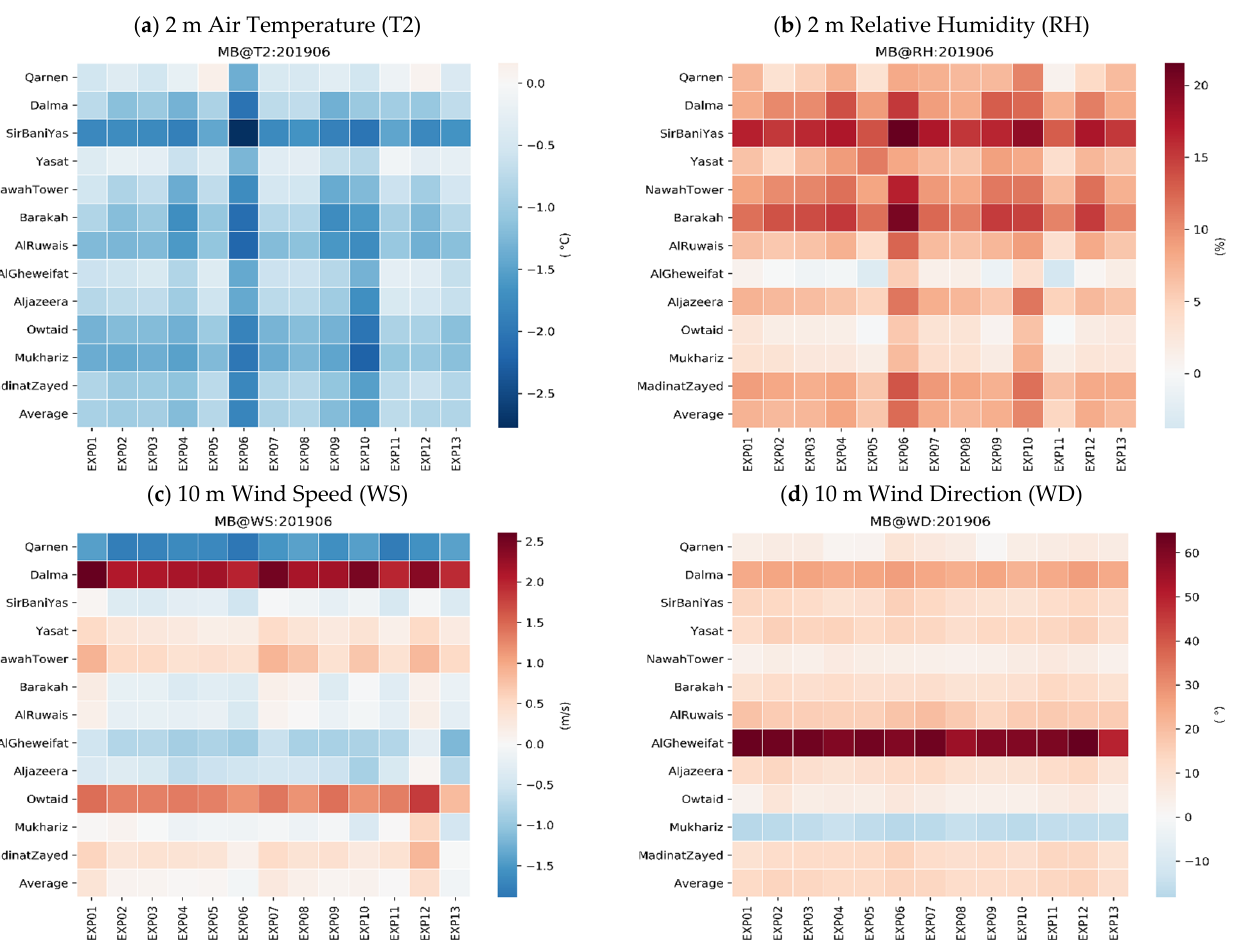
Figure 3. Mean Bias metric ( MB ) between station data and the conducted model experiments calculated using June 2019 hourly data for the surface parameters 2m air temperature (T2) and relative humidity (RH), wind speed (WS), and wind direction (WD) at 10 m above the ground. The last lines of the heatmaps show average values over all stations.